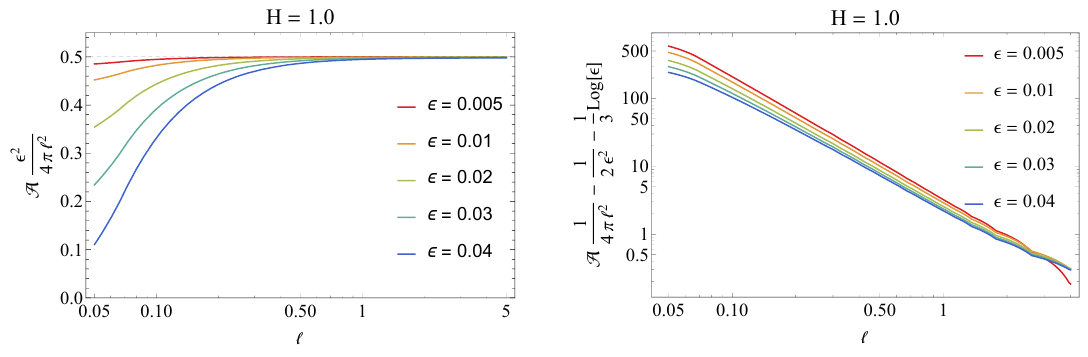
Figure 12 . Entanglement entropy for our H = 1 . 0 (left), rescaled by the area and cut-off (cid:15) 2 , together with the leading order divergence subtracted (right), for different values of the cut-off. the horizon is for H = 1 approximately given by t ≈ − 0 . 3 − log( ‘ ) . In combination with Ent a ( t ) = e Ht and S ( z ) ≈ 0 . 69 this implies that the part of the surface 9 hovering the 0 Ent entanglement horizon has an area 4 π‘ 3 0 . 134 /‘ 3 ≈ 0 . 559 which is only a constant term as 3 opposed to the usual volume scaling of the time independent